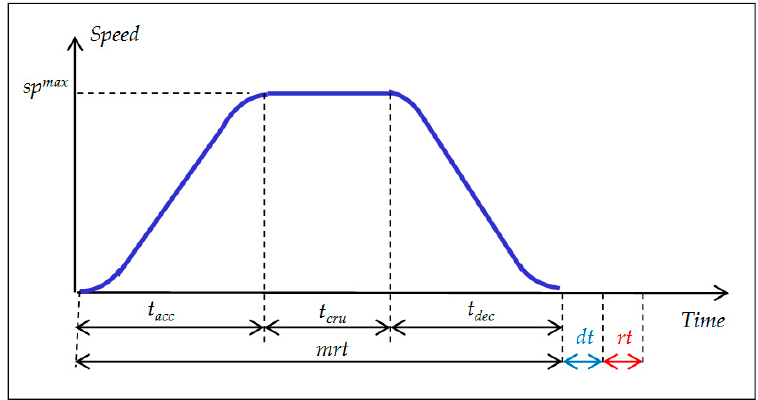
Figure 2. Time-optimal driving style. t acc , the duration of the acceleration phase; t cru , the duration of the cruising phase; t dec , the duration of the deceleration phase; sp max , the maximum travel speed.